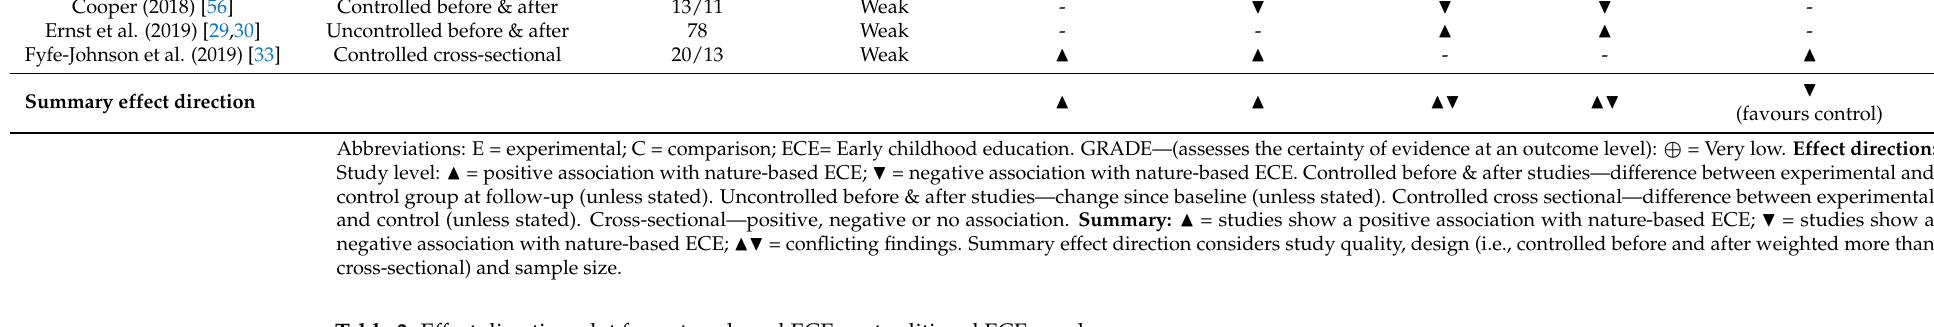
Table 3. Effect direction plot for nature-based ECE vs. traditional ECE on